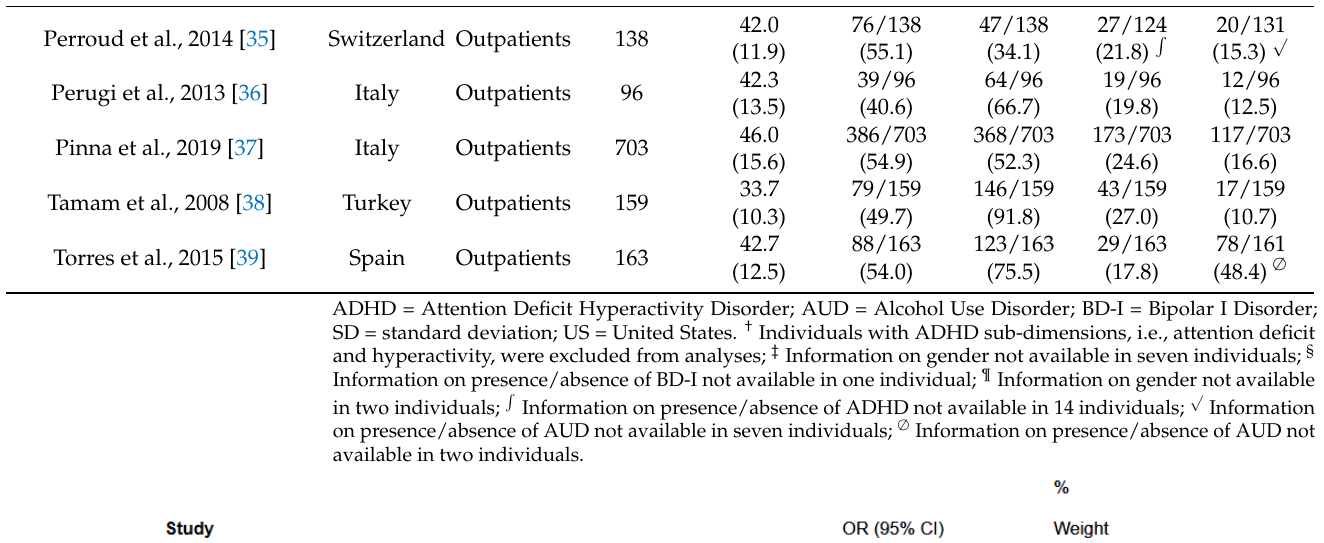
Table 2. Influence on effect size of study-level characteristics: meta-regression analyses.